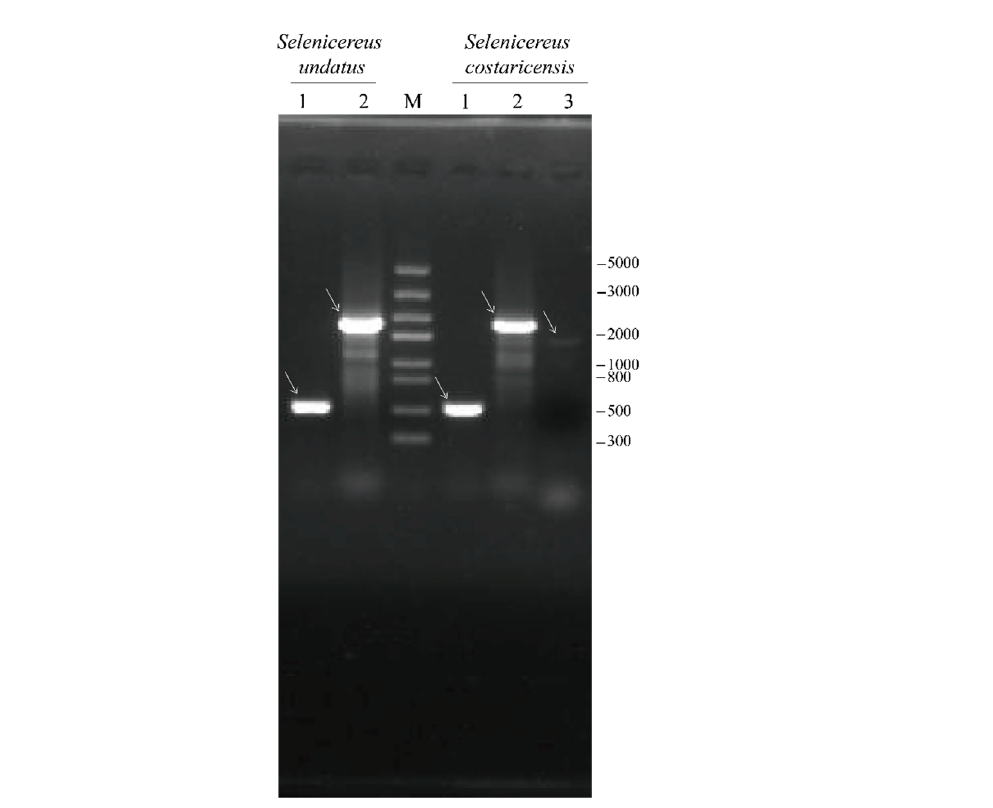
Figure 4. Agarose gel (1%) electrophoresis analysis of the RT-PCR products. Lane of 1, 2, and 3: correspond to the RT-PCR products for the CDSs of cupin , hsp 70 , and hsp sti 1 , respectively. The M line corresponds to DNA markers and their corresponding weight (bp). The main RT-PCR products are marked with white arrows.